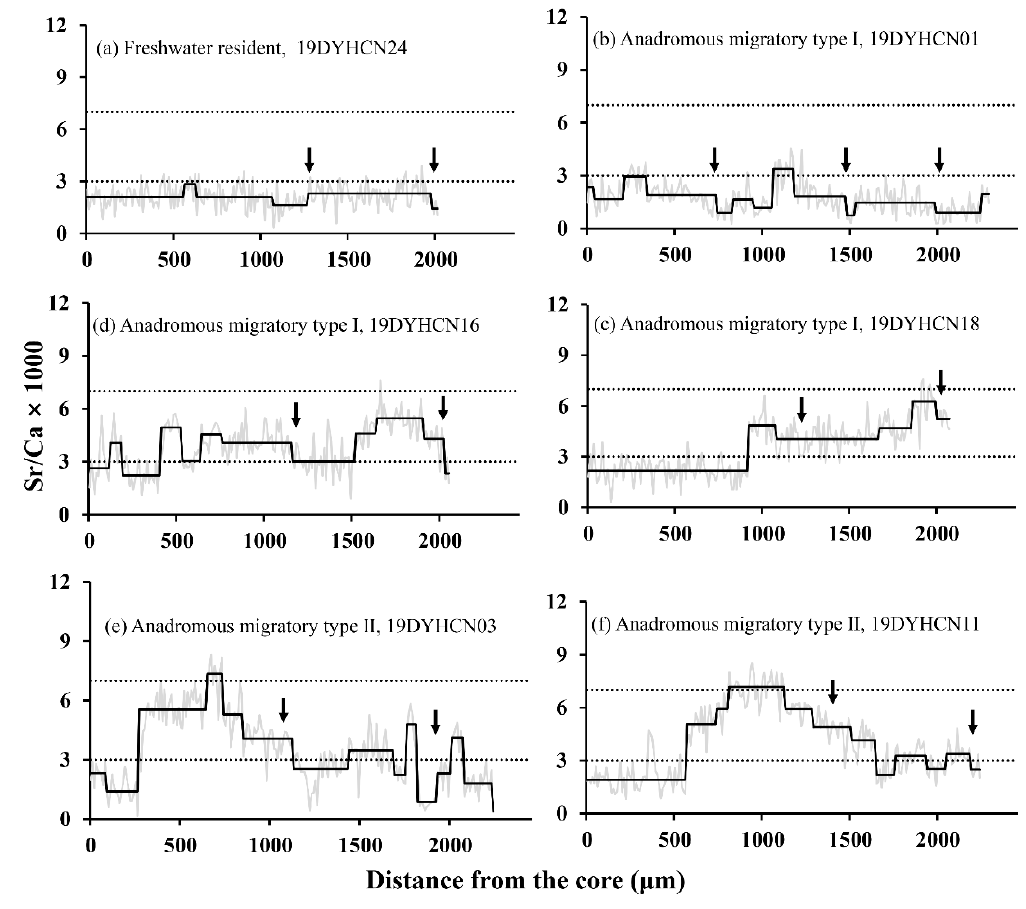
Figure 2. Representative otolith core-to-edge Sr/Ca patterns of freshwater resident ( a ), anadromous migratory Type I ( b – d ), and Type II ( e , f ) of C. nasus individuals. The gray lines and wide black lines show the fluctuations in the Sr/Ca ratios and shifts, respectively. The two horizontal imaginary lines denote reference boundaries for dividing Sr/Ca ratios as freshwater ( ≤ 3), brackish water (3–7), and sea water (>7). The black arrows indicate the positions of the